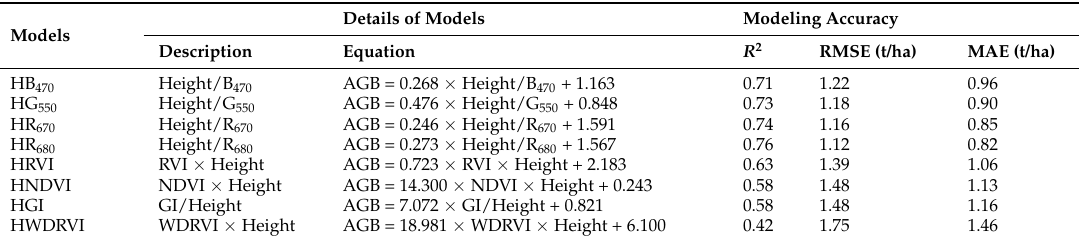
Table 4. Details of the improved AGB